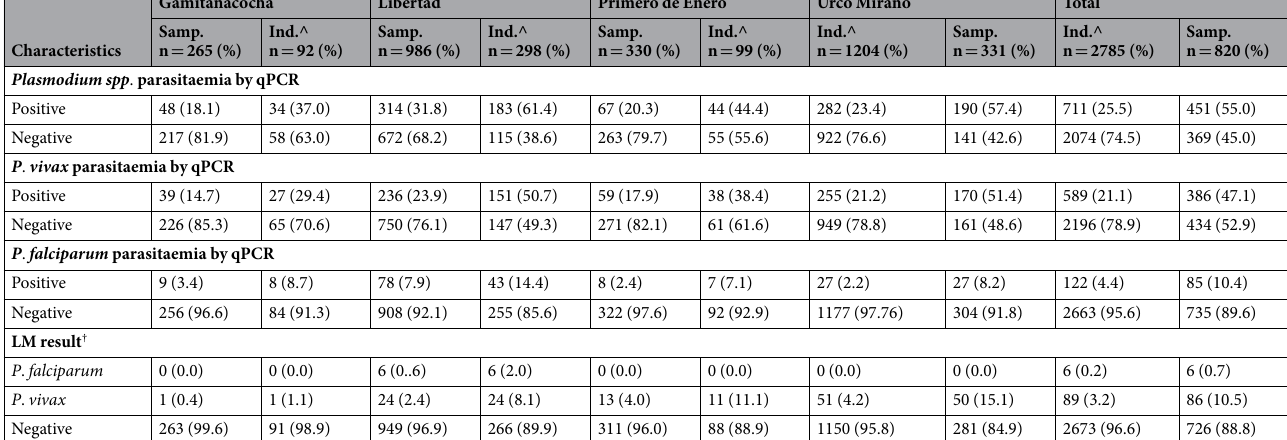
Table 2. Malaria parasite prevalence (by microscopy and PCR) by blood samples and individuals. Samp. = Samples; Ind. = Individuals; LM = Light microscopy; ^ At least in one positive in the four surveys; † Variables with missing